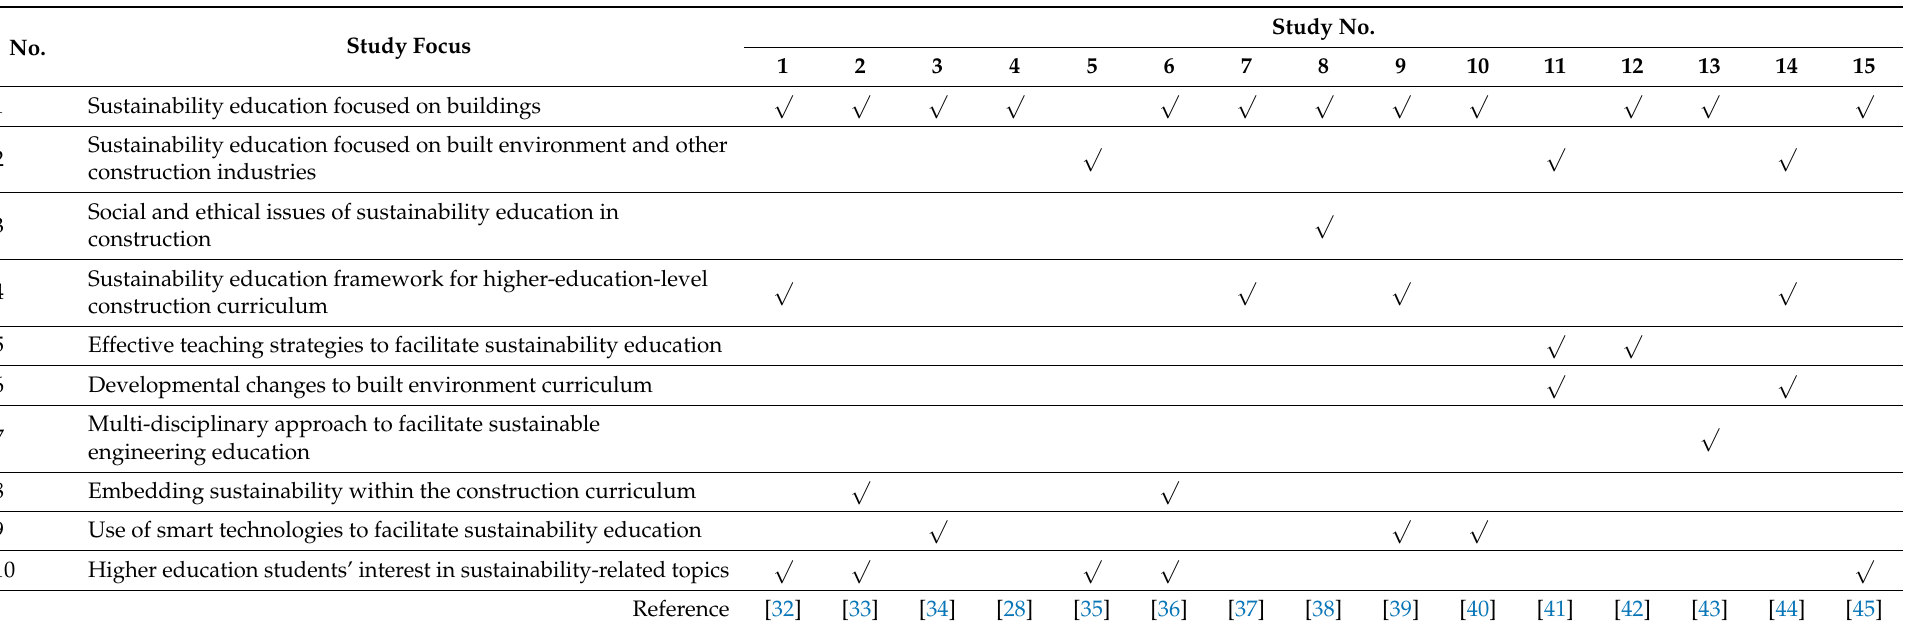
Table 1. Summary of previous study